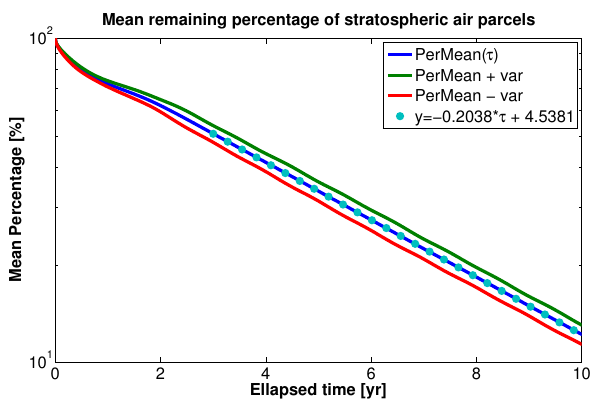
Fig. 1. Mean percentage of remaining air parcels in the stratosphere as a function of elapsed time τ (age). (Blue): mean over the 264 months of the 22-yr range. Basis 100 at time 0. (Green and red): mean ± one standard deviation. (Dotted): fit of the mean by the exponential decay law 93 . 48exp ( − 0 . 2038 τ) where τ is in yr.